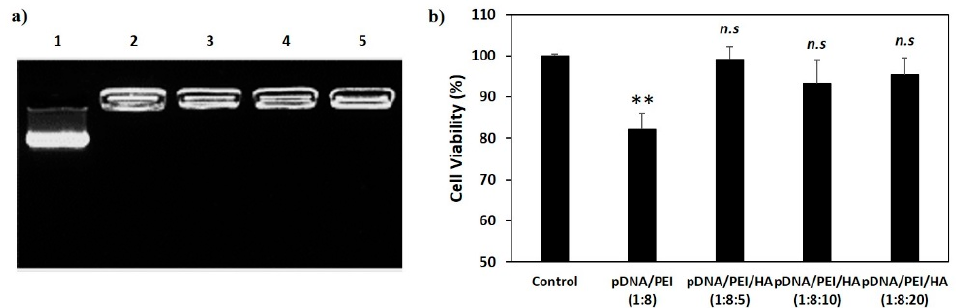
Figure 4. ( a ) Gel retardation assay of nanocomplexes. 1. Naked pDNA; 2. pDNA/PEI (1:8); 3. pDNA/PEI/HA (1:8:5); 4. pDNA/PEI/HA (1:8:10); and 5. pDNA/PEI/HA (1:8:20); ( b ) Viability of hASCs